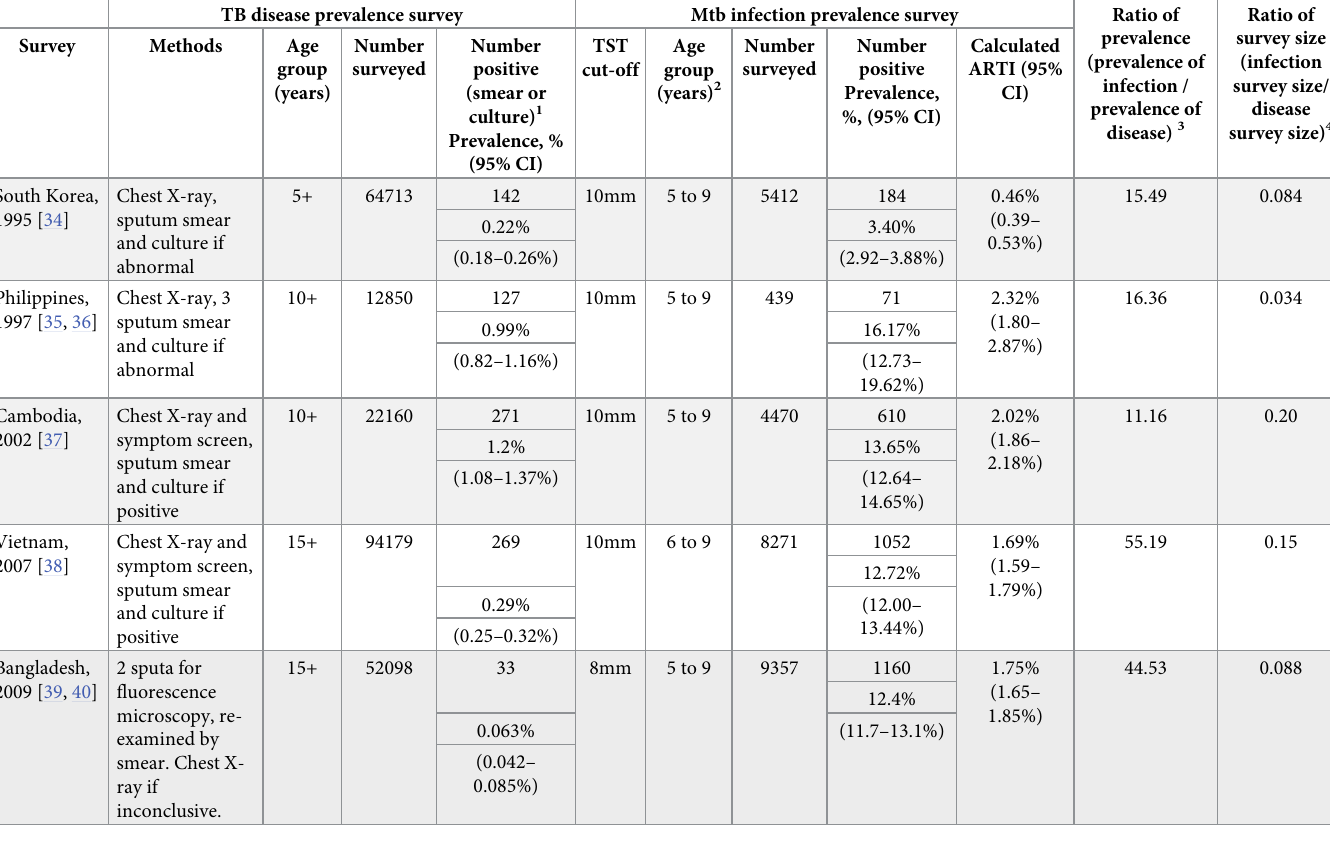
Table 1. The ratio of prevalence of Mtb infection in children aged 5–9 years and TB disease in the population, in national surveys since 1993 in which surveillance has been performed simultaneously for infection and